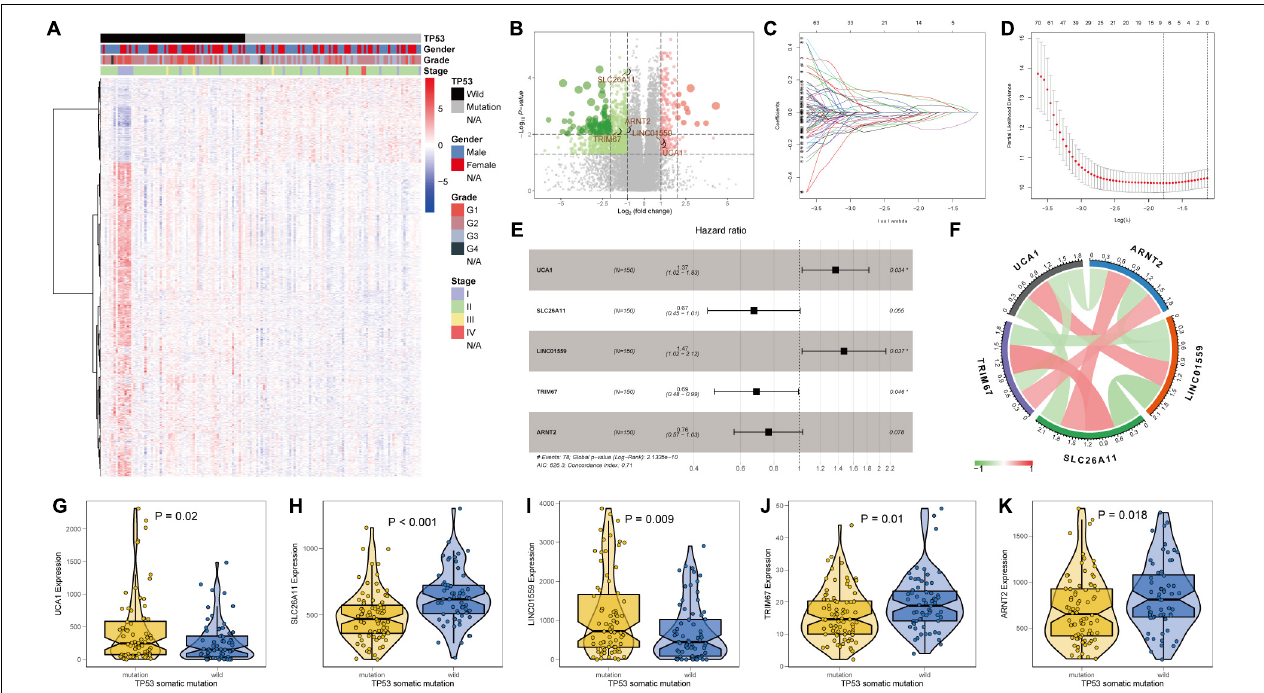
FIGURE 2 | Identification of differentially expressed genes (DEGs) and construction of a TP53-associated signature. (A) Heat map and (B) volcano plot of DEGs between pancreatic cancer (PC) samples with and without TP53 mutation. Five genes enrolled in the signature were emphasized. (C) Least absolute shrinkage and selection operator (LASSO) coefficient profiles of 495 genes. (D) Five prognostic genes obtained from LASSO regression with 10-fold cross-validation using minimum lambda value. (E) Forest plot, (F) mutual correlations, and (G–K) relative mRNA expressions of urothelial carcinoma-associated 1 (UCA1), solute carrier family 26 member 11 (SLC26A11), long intergenic non-protein coding RNA 1559 (LINC01559), tripartite motif-containing 67 (TRIM67), and aryl hydrocarbon receptor nuclear translocator 2